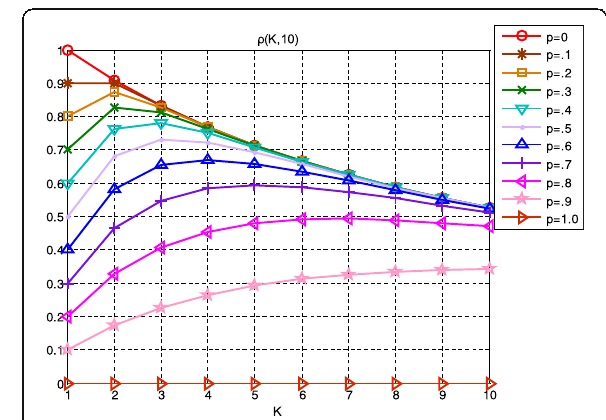
Fig. 4 ρ ( K , L ) for p = 0.4 Fig. 5 ρ ( K , 10) for different values of